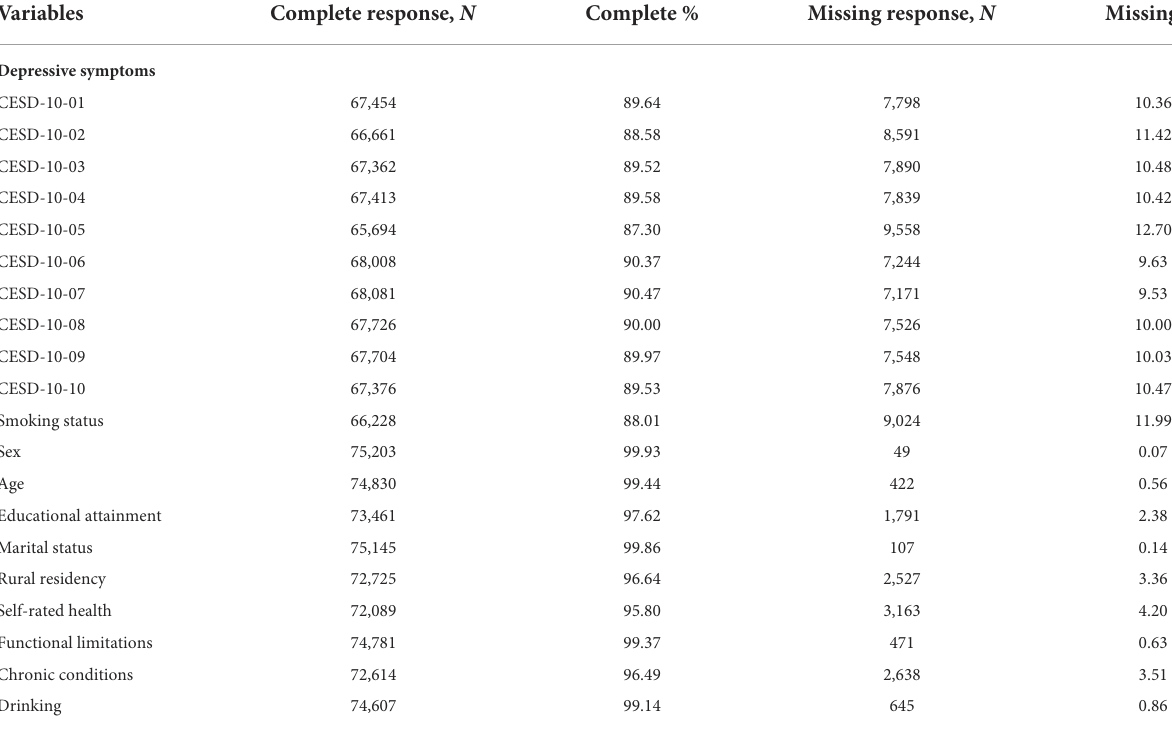
TABLE 1 Frequencies and percentages of missing values for the measured variables. Variables Complete response, N Complete % Missing response, N Missing